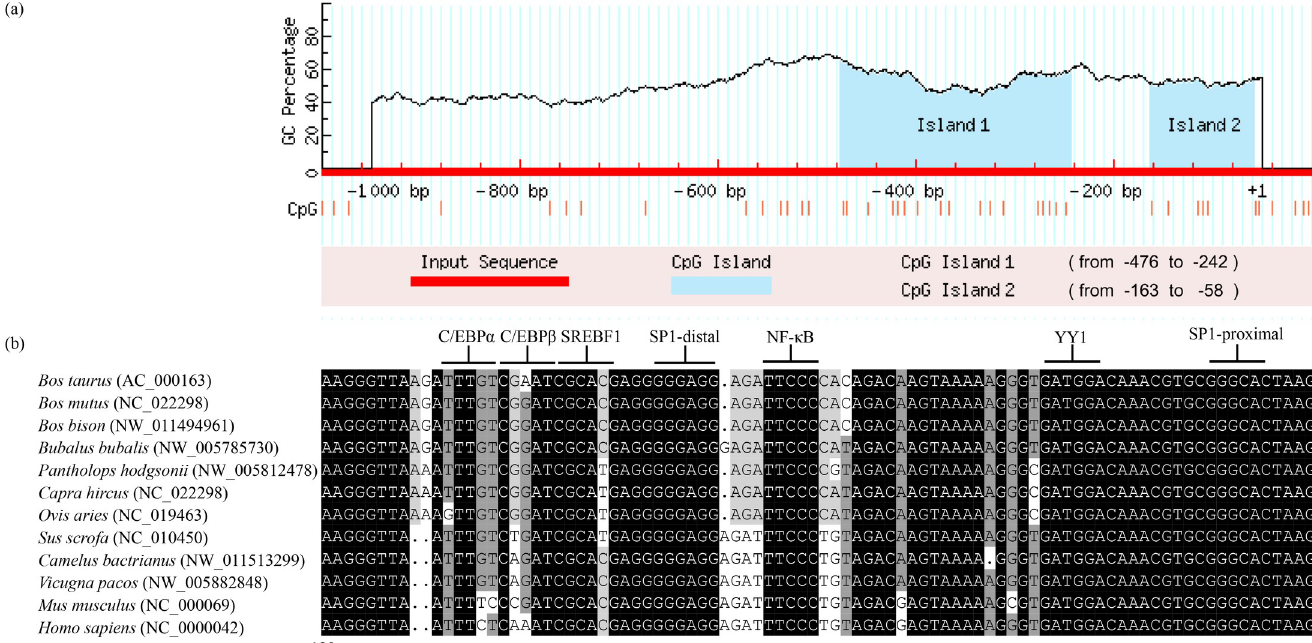
Fig 3. The prediction and analyses of CpG islands in bovine ELOVL6 promoter. ( a ) The predicted CpG islandsin the bovine ELOVL6 promoter(+1 to -1000 bp). The red vertical illustratedthe GC-rich regions. The blue shadingregions indicatedthe predicated CpG islands; ( b ) Multiple sequencealignment of the second CpG island. Seven predictedtranscription factors bindingsites were underlined. Black shaded sequencesindicatedthat the base pair was identicalin all sequencesof the alignment. Dark grey shadowindicatedconservedsubstitutionsand light grey shadowillustratedsemi-conserved